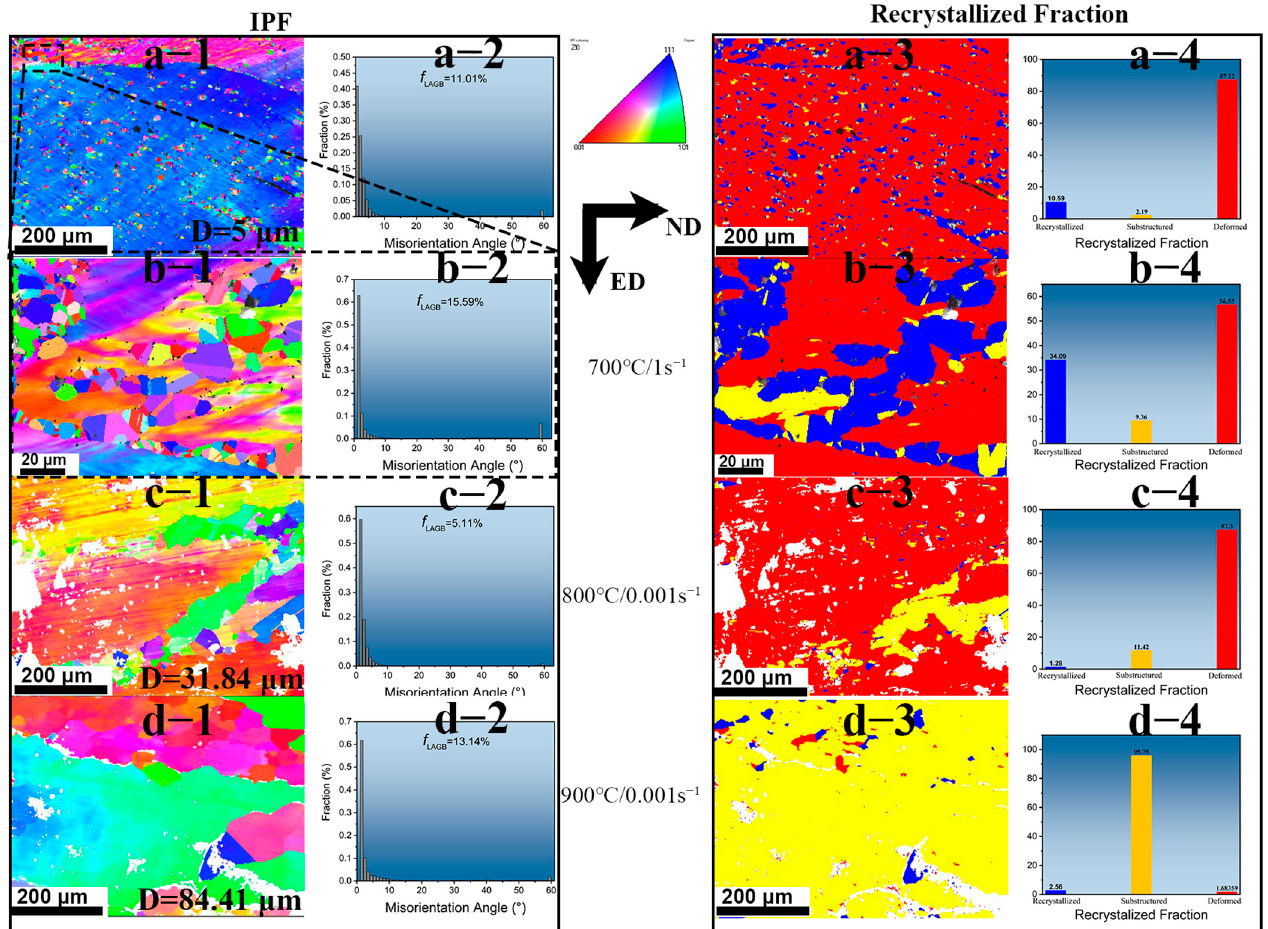
Figure 10. 1/2/3/4 are the IPF map/the percentage of grain boundary fraction/recrystallized distribution maps/frequency of recrystallized grain at the center of the sample deformed at: ( a ) 700 ◦ C/1 s − 1 ; ( b ) black frame selection from 700 ◦ C/0.001 s − 1 ; ( c ) 800 ◦ C/0.001s − 1 ; ( d ) 900 ◦ C/0.001s − 1 , respectively.